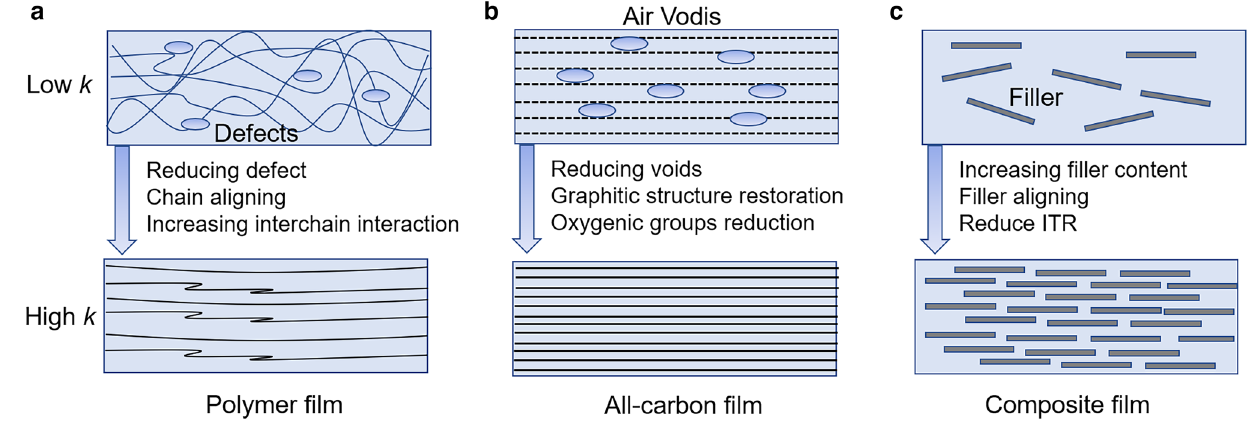
Fig. 4 The construction of thermal transport pathways in different kinds of films: a polymer film, b all‑carbon film, and c composite